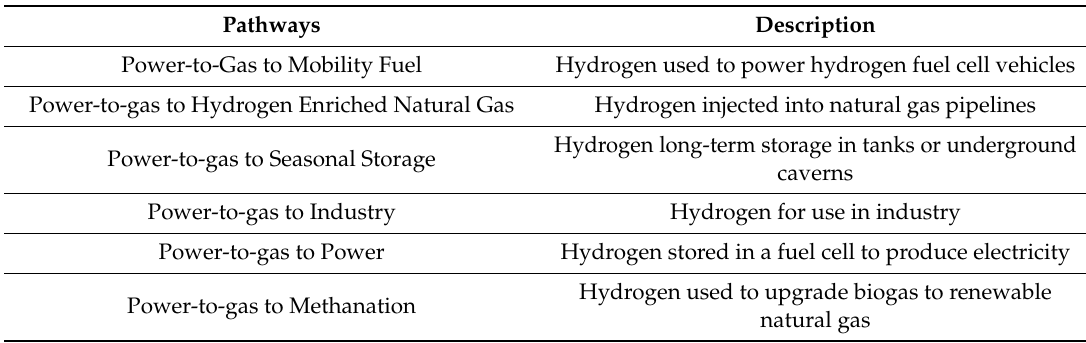
Table 1. Power-to-gas